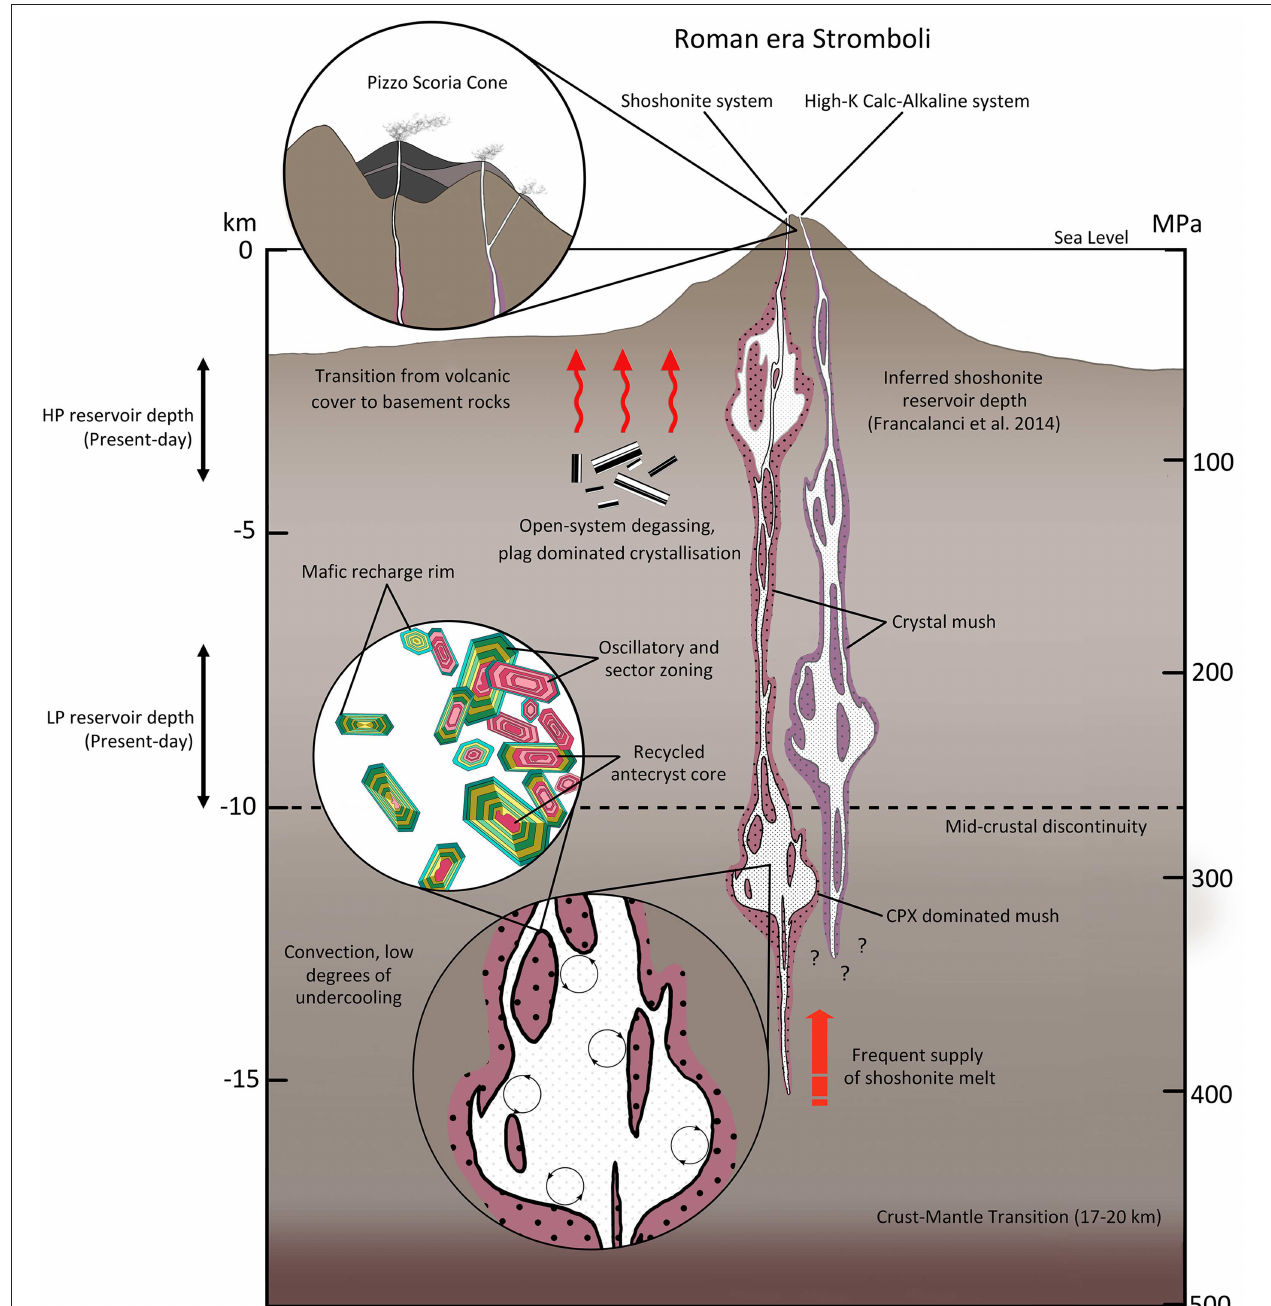
FIGURE 9 | Working model for the extended plumbing system at Stromboli volcano during Pizzo (Roman) times. Clinopyroxene megacrysts crystallised below the 10km mid-crustal discontinuity (Morelli et al., 1975), deeper than the reservoir depths inferred for Pizzo, Post-Pizzo, and Present-day activity based on olivine-hosted melt inclusions (Aiuppa et al., 2010; Métrich et al., 2010; Francalanci et al., 2013; double-headed arrows mark the depth ranges of current HP-LP reservoirs). The megacrysts grew from incremental replenishments and convection of shoshonite magma under conditions of low undercooling, generating mild concentric and oscillatory zonations which sometimes overgrow inherited cores. As suggested by Francalanci et al. (2014), the Roman-age feeding systems of the shoshonite subgroup (studied through clinopyroxene megacrysts here) and the high-K calc-alkaline subgroup were independent. The magnifying glass at the top highlights eruptive relationships between the two magmas. The lack of Mg-rich (diopsidic) bands in the studied megacrysts, typical of Post-Pizzo and Present-day clinopyroxenes (Petrone et al., 2018), suggests that the inception of the steady-state activity may be related to the invasion of the plumbing system with mafic magma in the last two millennia, after eruption of the megacrysts. The crust-mantle transition under Stromboli has been inferred at 17km (Panza et al., 2007; Métrich et al., 2010) to 20km (Laiolo and Cigolini, 2006), and the interface between volcanic rocks and the basement lies at about 2.4–3.5km depth (Di Roberto et al., 2008); both transitions are denoted by transitional grading in the